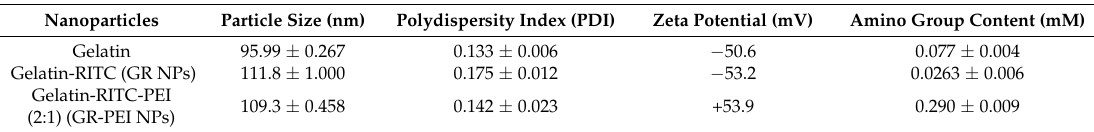
Table 1. Physical properties of